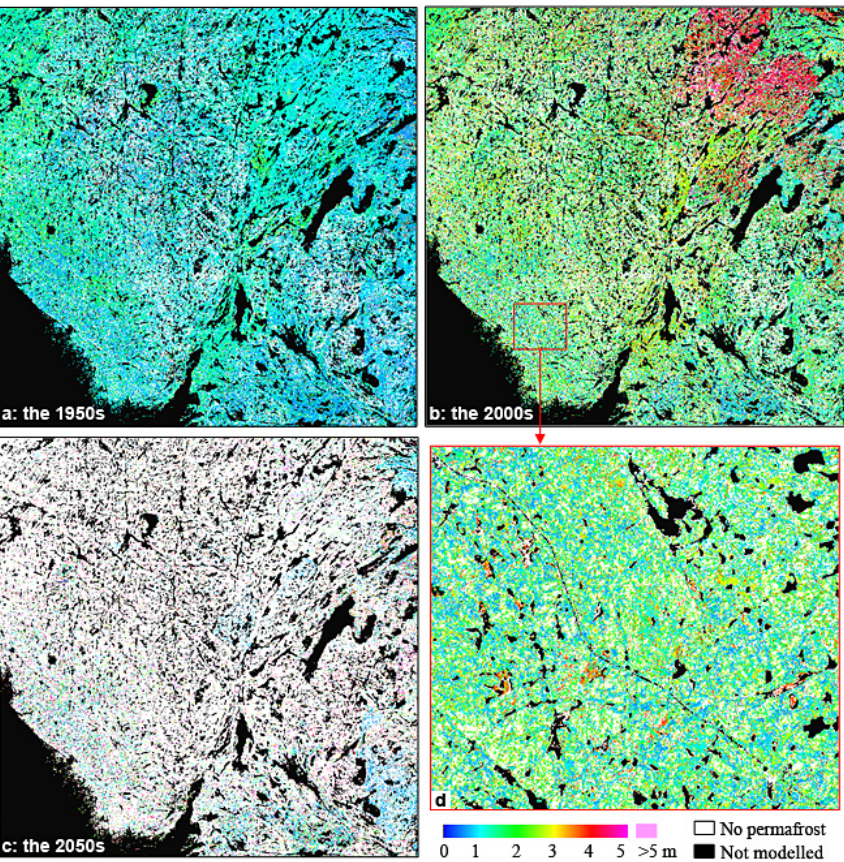
Figure 7. Modelled most likely active-layer thickness in the 1950s, 2000s and 2050s ( a , b , and c , respectively). (d) shows an enlarged area in (b) . This figure also shows the most likely distribution of permafrost (white for non-permafrost areas and the other colours for areas with